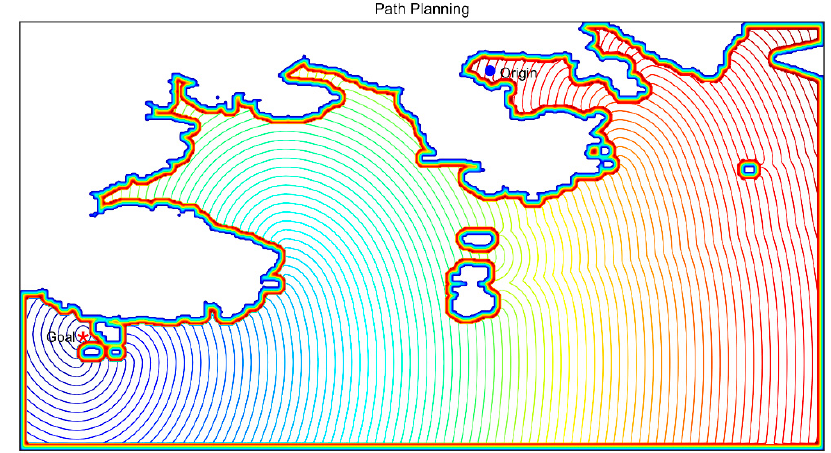
Figure 23. LSM potential field.